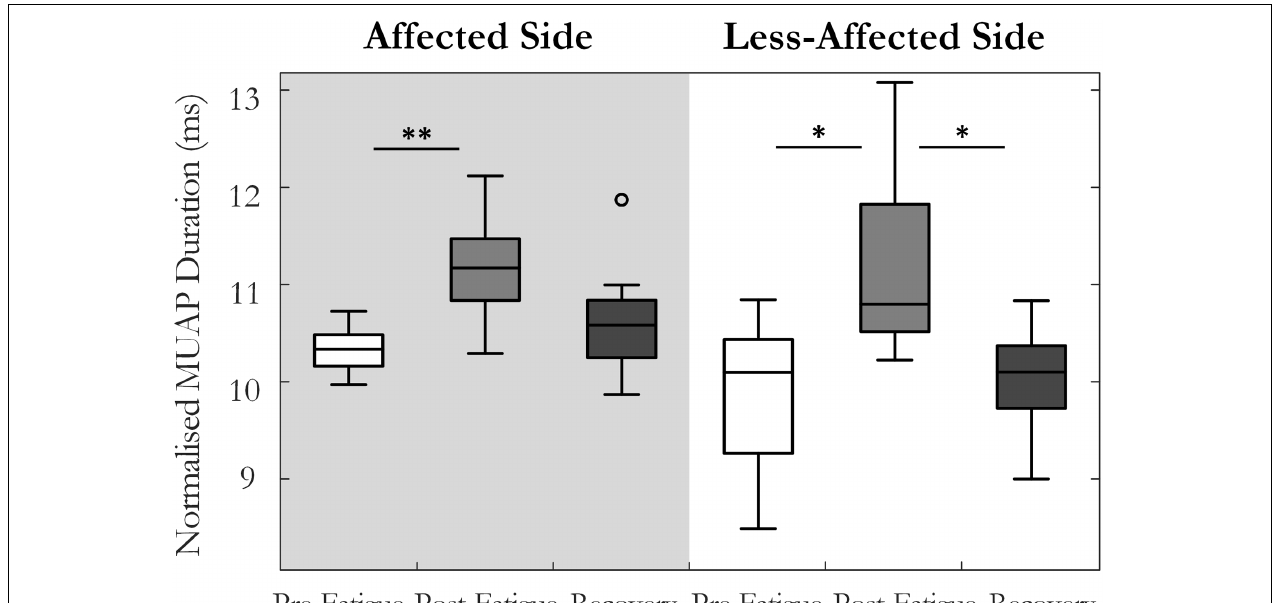
FIGURE 5 | Median and interquartile range of the median MU action potential duration across all subjects from MUs detected pre-fatigue, post-fatigue, and after the recovery period, on both the affected and less-affected sides ( ∗ p < 0.05, ∗∗ p < 0.01).